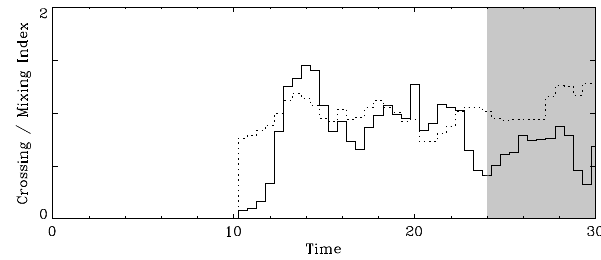
Fig. 8. Number of particles crossing the MP depending on final pitch-angle and assuming an initially isotropic distribution.